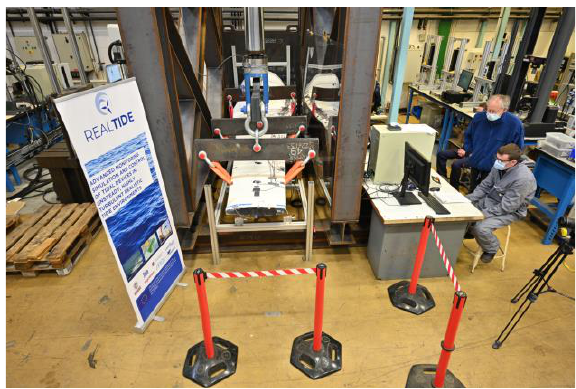
Fig. 15. Blade on test frame during test.